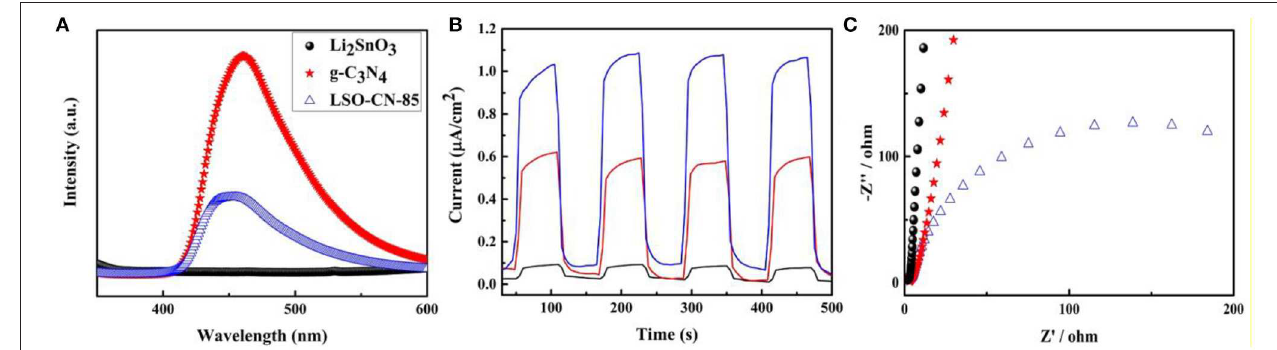
FIGURE 6 | (A) PL spectra at the excitation wavelength of 320nm. (B) Transient photocurrent responses. (C) EIS Nyquist plots of the as-prepared samples Li 2 SnO 3 , g-C 3 N 4 and